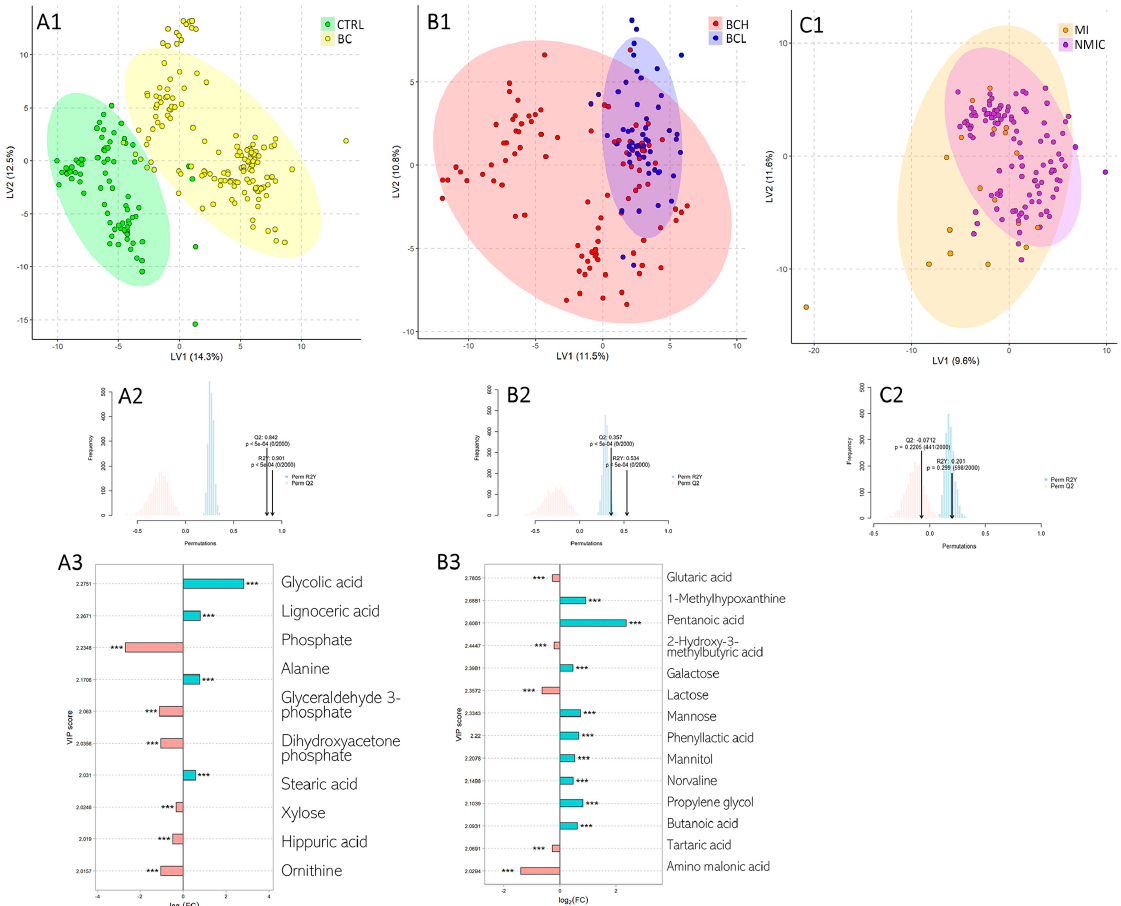
Figure 2. Partial least square discriminant analysis (PLS-DA) models score plot used to classify (panel A ) healthy and bladder cancer subjects; (panel B ) bladder cancer patients according to their grade (high-grade BCH, or low grade BCL); and (panel C ) bladder cancer patients according to the muscle invasiveness (non-muscle invasive NMIC, or muscle invasive MIC). The percentage of explained variance was reported in parentheses on each axis. Row 1 reports the PLS-DA score plot, while row 2 shows the histogram of the permutation test results in terms of R 2 and Q 2 . Row 3 reports the metabolites having a VIP-score ≥ 2.0. In A3, the blue bars represent metabolites increased in CTRL, while the red bars represent the metabolites decreased in CTRL with respect to BC. In B3, the blue bars represent the metabolites increased in BCH, while the red bars represent the metabolites decreased in BCH with respect to the BCL. *** indicates statistically significant ( p <